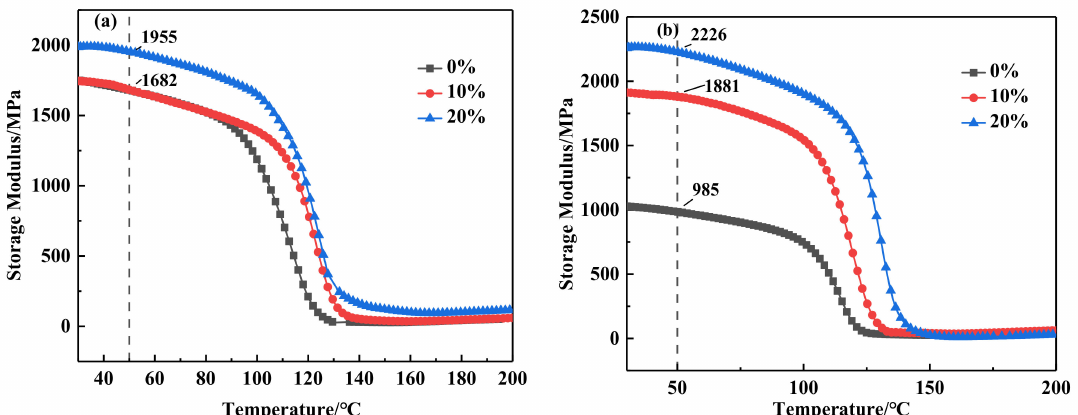
Figure 6. Storage modulus-temperature spectrum of each resin system under different aging con- ditions ( a ) Stoage modulus of cycloaliphatic blend resins with different proportions without aging ( b ) Storage modulus of cycloaliphatic blend resins with different proportions after 28 days salt